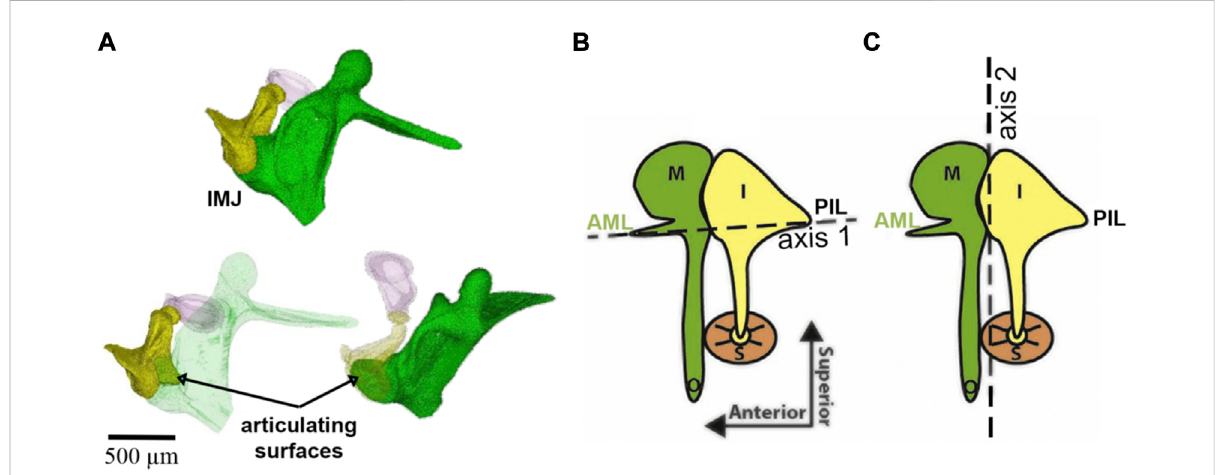
FIGURE 6 Panel (A) shows the incudomalleolar joint and articulating surfaces of a mouse ear. A synovial- fl uid- fi lled gap between malleus and incus exists (Ihrle et al. (2017). Panels (B) and (C) were taken from (Rosowski et al., 2020) and modi fi ed. The malleus (M), incus (I), stapes (S), anterior mallear ligament(AML),andposteriorincudalligament(PIL)areshown.Thedottedlinesshowtwoaxesofossicularrotation,oneinpanel (B) andoneinpanel (C) .Theaxisin (B) isaxis1 atlowfrequenciesinthefreely-mobileear(Helmholtz,1868;Fleischer,1978;PuriaandSteele,2010);panel (C) shows the freely-mobile ear with the high-frequency axis 2 of